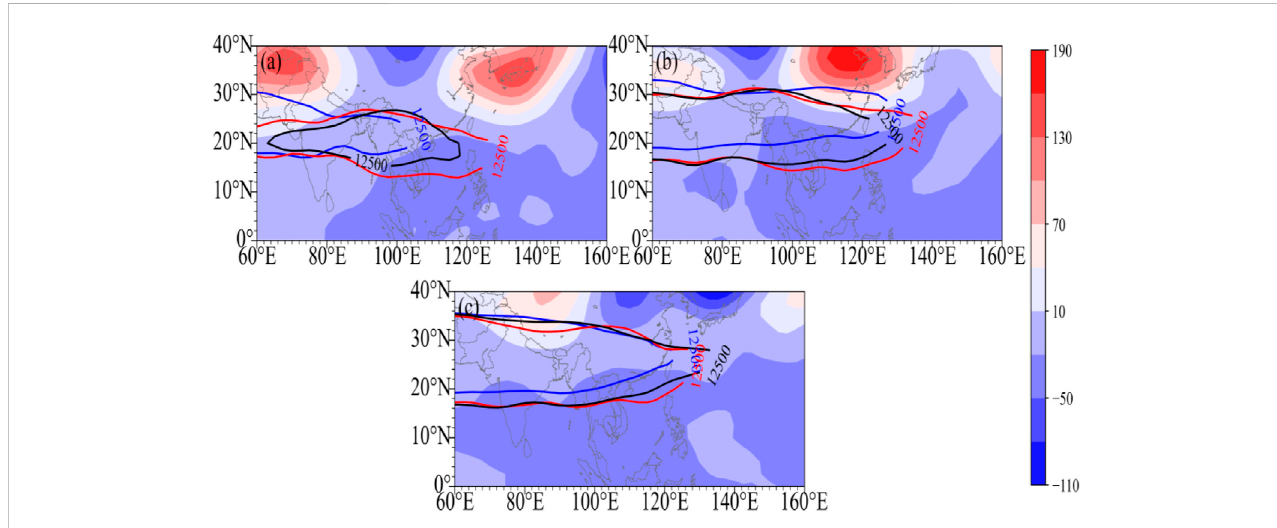
FIGURE 2 Comparative analysis of 200 hPa geopotential height (A) . June 5th, (B) . June 17th, (C) . June 28th, unit: gpm) (Shaded area: the difference between early years and late years, contour: South Asia High (12500 gpm), blue: early years, red: late years, black: climatic